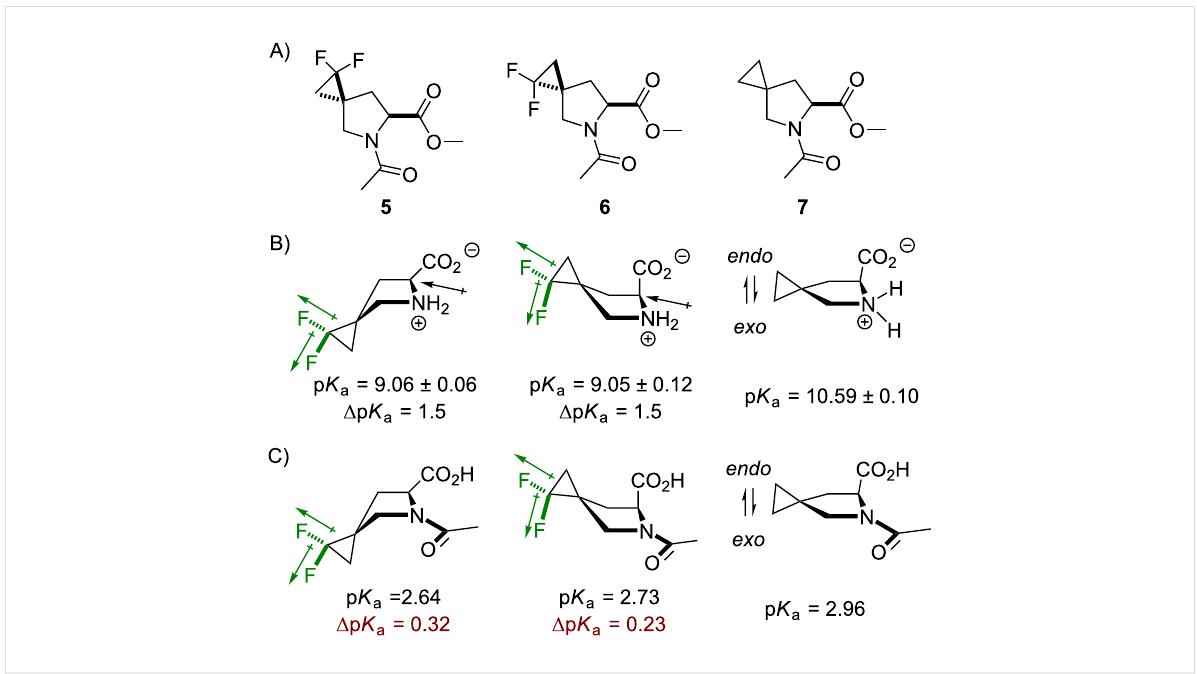
Figure 10: A) The structures of difluorinated model compounds 5 and 6 , and the fluorine-free reference 7 . B) Basicity data for the corresponding amino acids. C) Acidity data for the s- cis N -acetylamino acids. The error is ± 0.05.